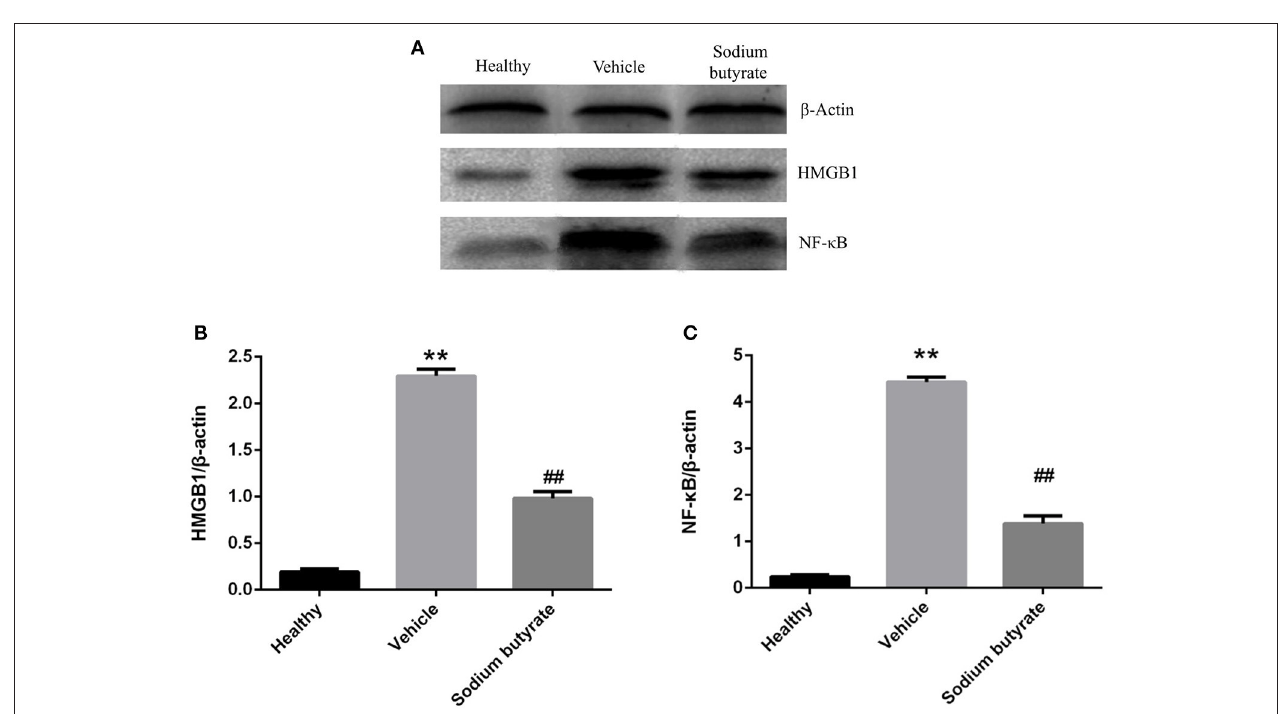
FIGURE 5 | Sodium butyrate inhibits the pancreatic HMGB1 and NF- κ B p65 protein expression (A) . Western blot analysis of pancreatic HMGB1 and NF- κ B p65 protein expression from sodium butyrate group ( n = 5), vehicle group ( n = 5), and healthy group mice ( n = 3). Both HMGB1 and NF- κ B p65 expression were increased in diabetic mice compared with healthy group, however, sodium butyrate down-regulated their expression (B,C) . Quantitative analysis of A results are representative of three independent experiments and data represent the mean ± SD. ** p < 0.01 vs. healthy group, ## p < 0.01 vs. vehicle group.